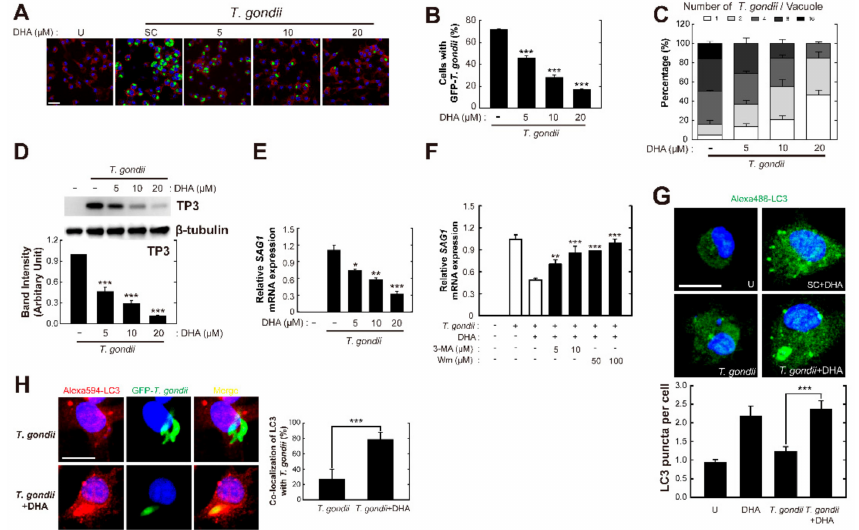
Figure 2. Docosahexaenoic acid (DHA)-induced autophagy activation results in the elimination of intracellular T. gondii in primary macrophages. ( A – C ) BMDMs were infected with T. gondii GFP-RH strain (MOI = 1) then incubated with DHA at indicated concentrations for 18 h. ( A ) The number of GFP-RH strain were analyzed using confocal microscopy. ( B and C ) GFP-RH-infected cells ( B ) and GFP-RH strain per vacuole ( C ) were counted. Scale bar = 25 µ m. ( D and E ) BMDMs were infected with T. gondii RH strain (MOI = 1) for 2 h, and then incubated with increasing concentrations of DHA (5, 10, or 20 µ M) for 48 h. ( D ) Immunoblot analysis was performed to determine protein expression of TP3 and β -tubulin. A representative gel from three independent experiments with similar results is shown. (top), Densitometry analysis (bottom) ( E ) SAG1 mRNA expression was evaluated by qPCR analysis (bottom). ( F ) BMDMs were infected with T. gondii RH strain (MOI = 1), followed by treatment with 3-methyladenine (3-MA) (5 or 10 µ M; 2 h) or wortmannin (WM) (50 or 100 nM; 2 h), and then incubated with DHA (10 µ M) for 18 h. SAG1 mRNA expression was evaluated by qPCR analysis. ( G ) BMDMs were infected with T. gondii RH strain (MOI = 1) for 2 h, and then incubated with DHA for 18 h. Immunofluorescence microscopic analysis of LC3 puncta formation (top). Quantitative analysis of LC3 punctate foci per cell (bottom). Each experiment included at least 100 cells scored in 5 random fields. Scale bar: 10 µ m. ( H ) BMDMs were infected with T. gondii GFP-RH strain (MOI = 3) for 2 h, and then incubated with DHA for 18 h. Cells were observed by confocal microscopy (left); T. gondii GFP-RH (green), Alexa 594-conjugated LC3 (red), and DAPI (blue). Quantification of T. gondii and LC3 colocalization per cell with 100 internalized T. gondii (right). Scale bar: 10 µ m. Data in B, C, D, E, and G are means ± SD. Data in G are means ± SEM. Data are representative of three independent experiments. * p < 0.05, ** p < 0.01, *** p < 0.001, compared with solvent control (two-tailed Student’s t -test). U, untreated; SC, solvent